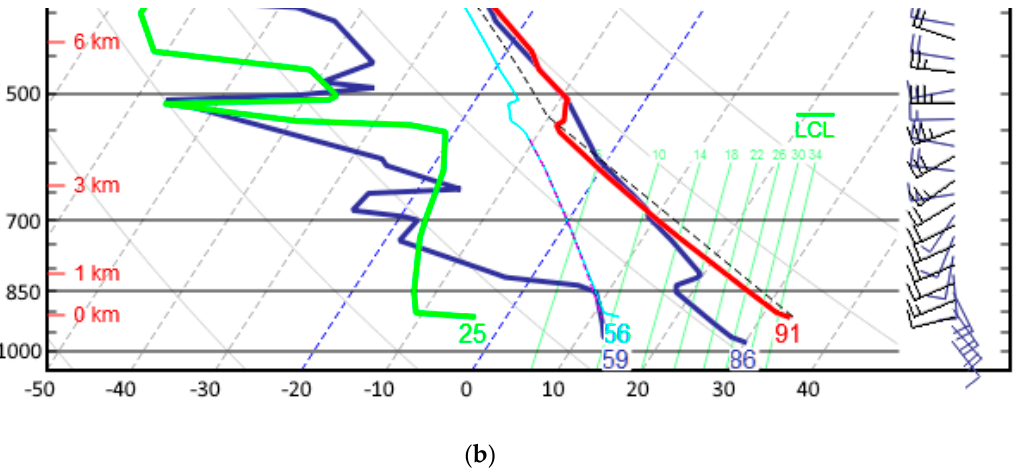
Figure 4. ( a ) Skew-T log-p plot comparing KDRT 0000 UTC sounding to HRRR (background, blue lines). ( b ) Observed soundings at 0000 UTC from KMAF (top; west of dryline) and KDRT (background; east of dryline).